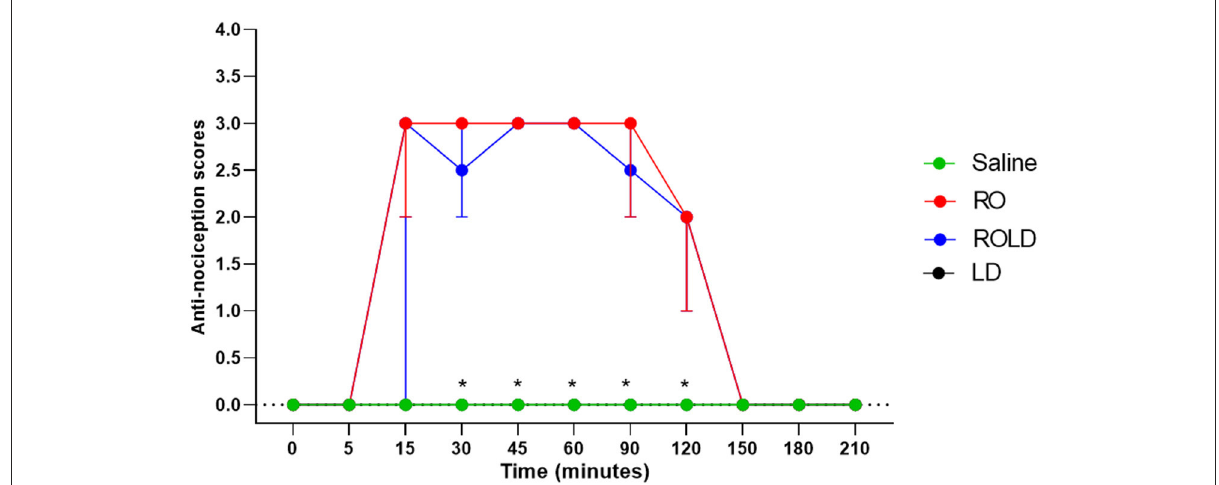
FIGURE3 Anti-nociception scores (median and range) in the hind limb stifle and hock regions (Response to “pin-prick” stimulation) pre- epidural and post- epidural administration of saline ( n = 6), romifidine (RO) (50 µ g kg − 1) ( n = 6), romifidine-lidocaine (ROLD) (50 µ g and 0.30mg kg − 1) ( n =